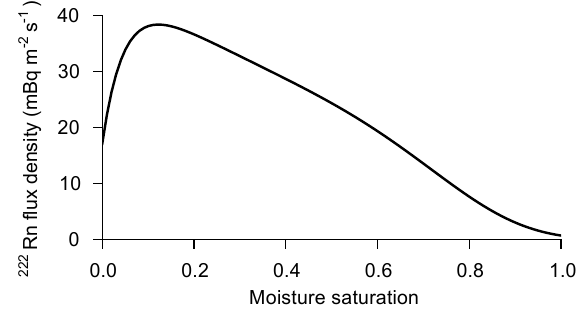
Fig. 1. Diffusive radon transport to the atmosphere versus soil moisture for a sandy loam (15% clay, 15% silt, 70% sand) according to Eq. (4), (5) and (6) with A Ra = 30Bqkg − 1 , ρ b = 1060kgm − 3 , (cid:15) = 0 . 4 , and T = 298K. At m ’ 0 . 03 and m ’ 0 . 40 the surface flux is 25% below its peak